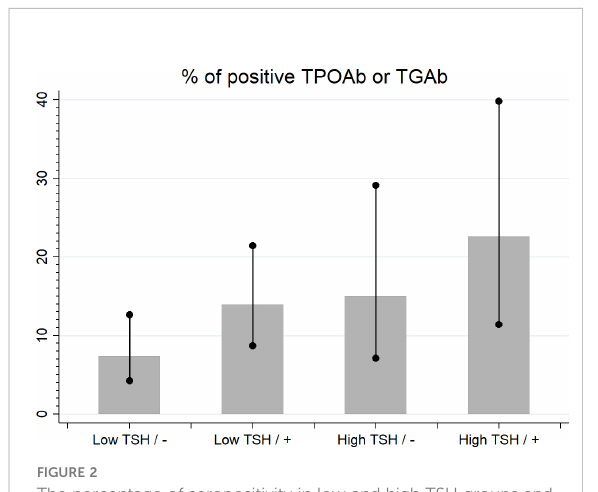
FIGURE 2 The percentage of seropositivity in low and high TSH groups and negative/positive family history of any thyroid diseases